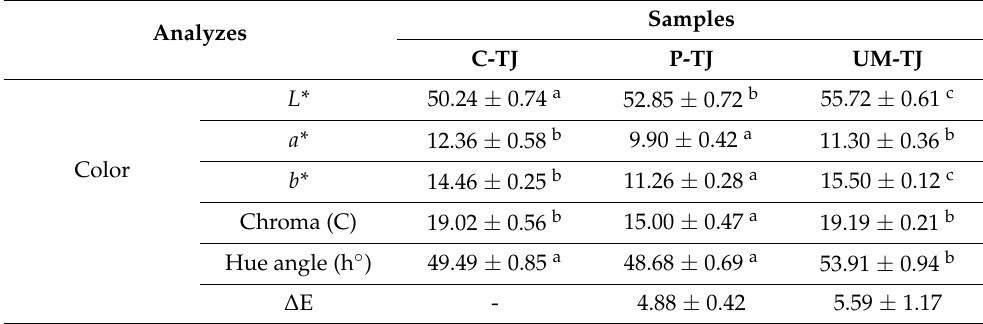
Table 7. Analysis results of color values of L * , a * , b * , C, and h ◦ of C-TJ, P-TJ, and UM-TJ samples.